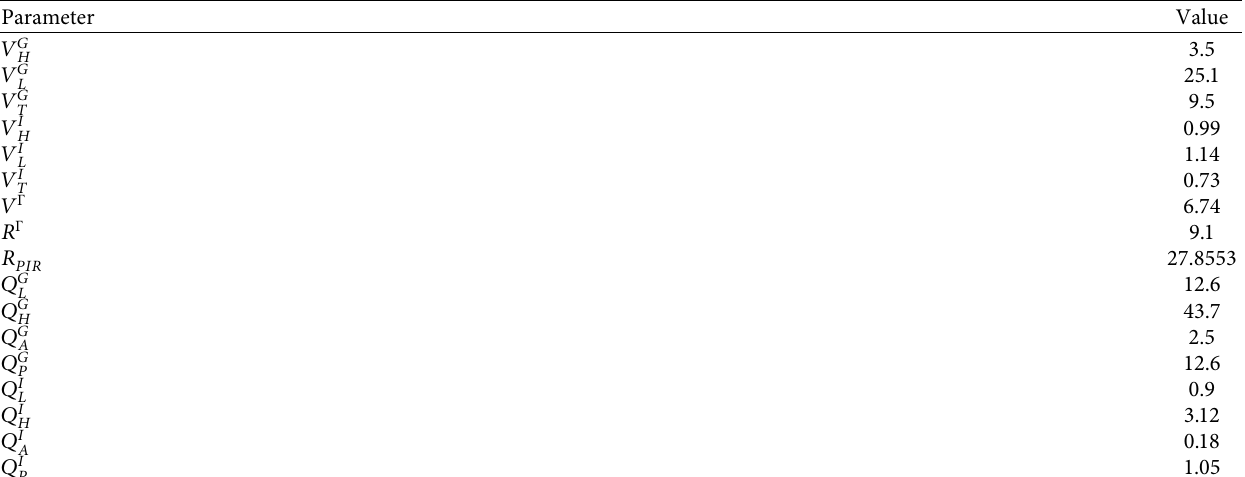
Table 3: Parameters used from